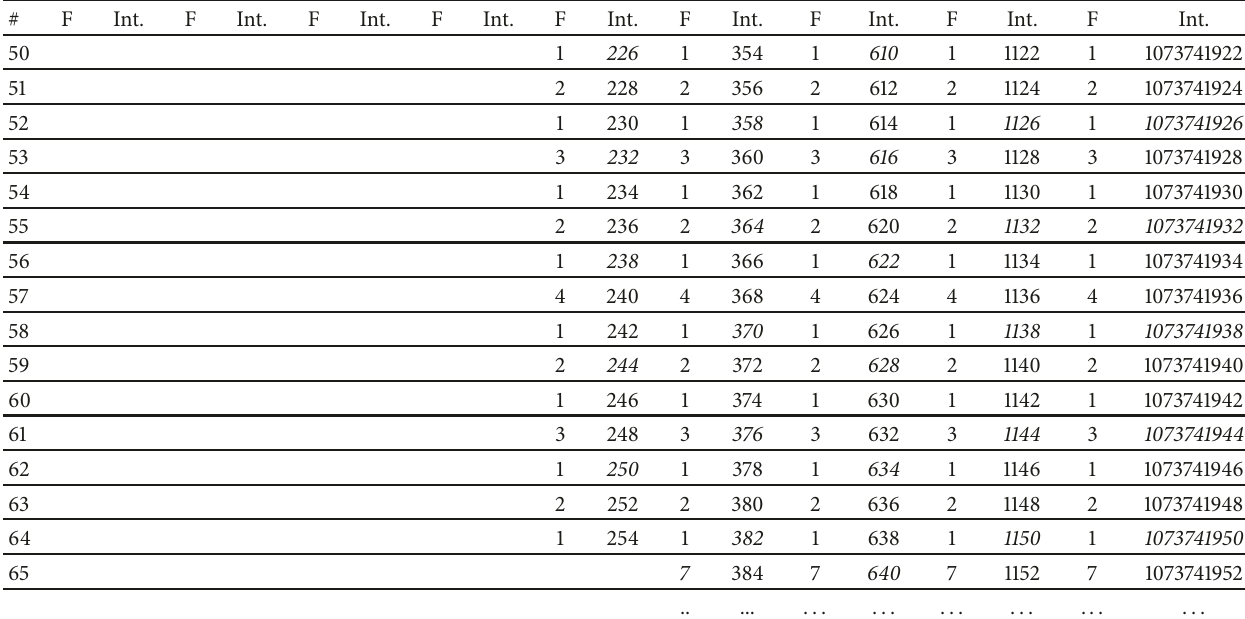
Table 2: Representative of pivotal RF in the table of positive even integers.